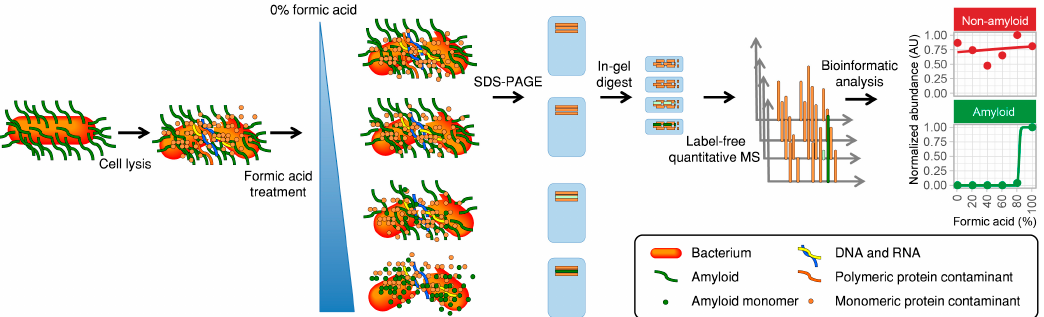
Figure 1. Direct identification of functional amyloid proteins using label-free quantitative (LFQ) Liquid chromatography–tandem mass spectrometry (LC-MS/MS). The sample is lysed and divided into aliquots that are lyophilized and treated with either 0%, 20%, 40%, 60%, 80%, or 100% formic acid. The samples are then lyophilized, dissolved in reducing sodium dodecyl sulfate polyacrylamide gel electrophoresis (SDS-PAGE) loading buffer, and subjected to short run SDS-PAGE. The amyloid proteins can only enter the gel if they have been pretreated with concentrated formic acid and are therefore only present in these samples. In-gel digestion is carried out with trypsin, and samples analyzed by label-free quantitative LC-MS/MS using MaxQuant and the MaxLFQ algorithm. The data is finally analyzed for each protein using an automated script, and positive amyloid candidates are identified based on their abundance profiles with respect to the formic acid concentration.